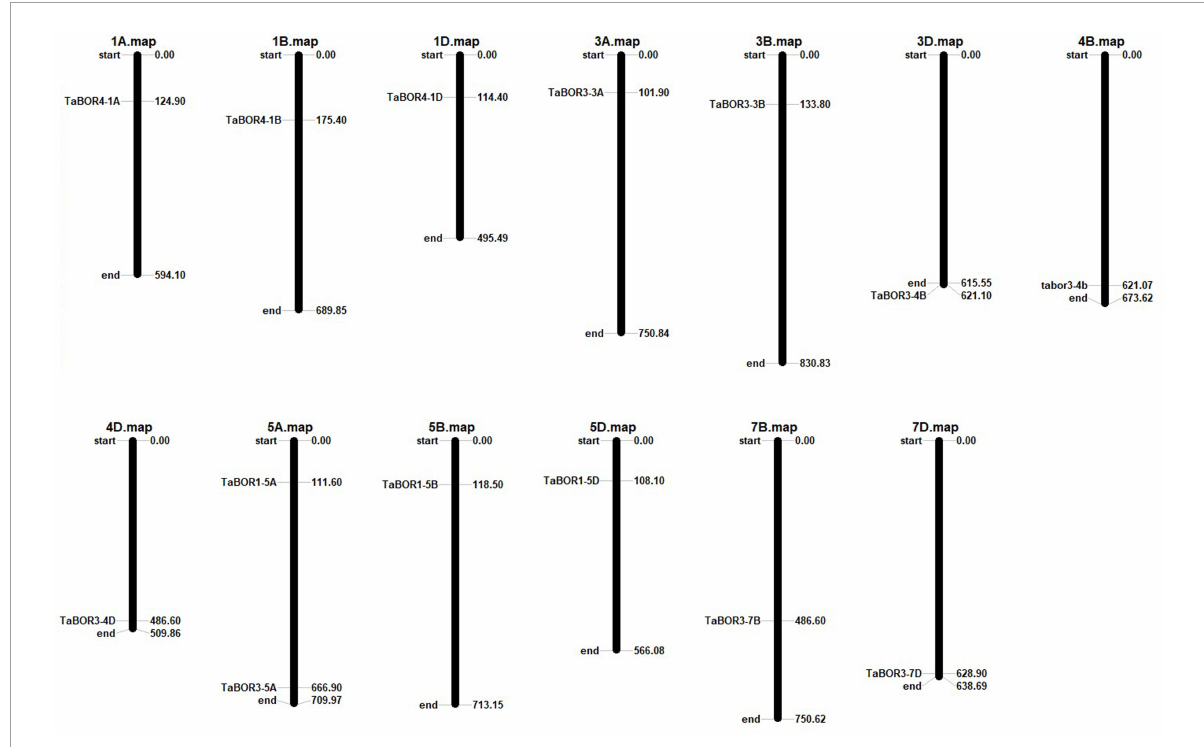
FIGURE4 Chromosomal distributions of TaBOR genes in common